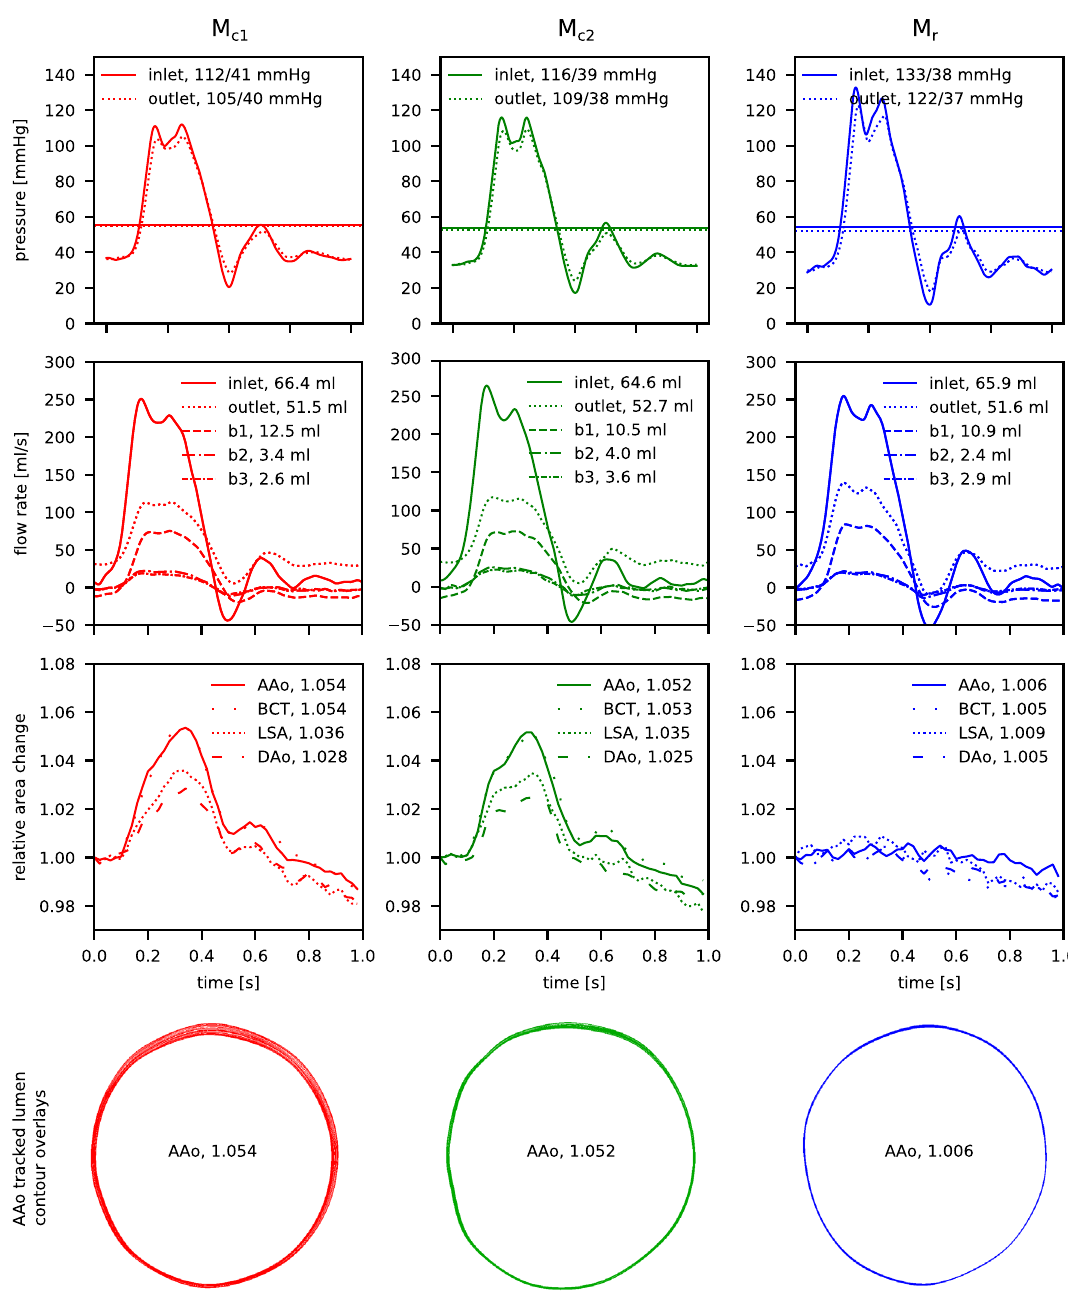
Figure 2. Experimental setup conditions for aorta models M c1 (red), M c2 (green), and M r (blue), evaluated at selected landmarks (Fig. 1g). (Row 1) Pressure conditions recorded at inlet (solid) and outlet (dashed). (Row 2) Flow rate waveforms at inlet and all outlets with calculated net flow volumes, based on 2D PC-MRI data. (Row 3) Cross-sectional area change relative to area at cardiac cycle start, based on tracked lumen contours in 2D-cine-GRE data. (Row 4) Overlay of tracked lumen contour at cross-section AAo for all acquired time frames (N = 50). Animated contour tracking results are presented in Supplementary Fig. S2. Plots created using Python (v3.6, https:// www. python. Figure 5 shows mean and maximum velocity analysis results. Maximum velocities at peak systole were highest in model M r (73.1 cm/s at AAo, 42.5 cm/s at BCT, 39.1 cm/s at LSA, and 43.2 cm/s at DAo) compared to both compliant models M c1 (73.0 cm/s at AAo, 38.5 cm/s at BCT, 35.4 cm/s at LSA, and 35.5 cm/s at DAo) and M c2 (70.5 cm/s at AAo, 36.6 cm/s at BCT, 35.5 cm/s at LSA, and 39.2 cm/s at DAo). Likewise, cross-sectional mean velocities in systole were higher in model than in the compliant models. Decreasing temporal sampling from 50 frames down to 16 frames showed greatest effects at the AAo landmark for peak velocity which decreased by 16%, 19 %, 14 % for M c1 , M c2 , and M r .